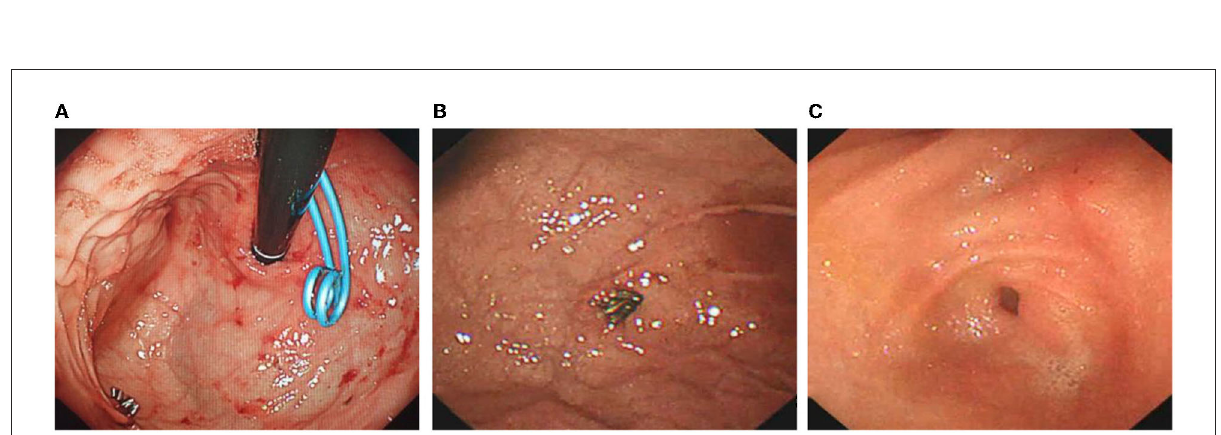
FIGURE5 Removal of stents under gastroscopy and review of Dieulafoy’s disease. (A) Gastric mucosa was smooth. (B) Titanium clips on the greater curvature side of the gastric fundus were well fixed, and no bleeding or other lesions were observed. (C) The double pigtail stents were removed, and no abnormalities were